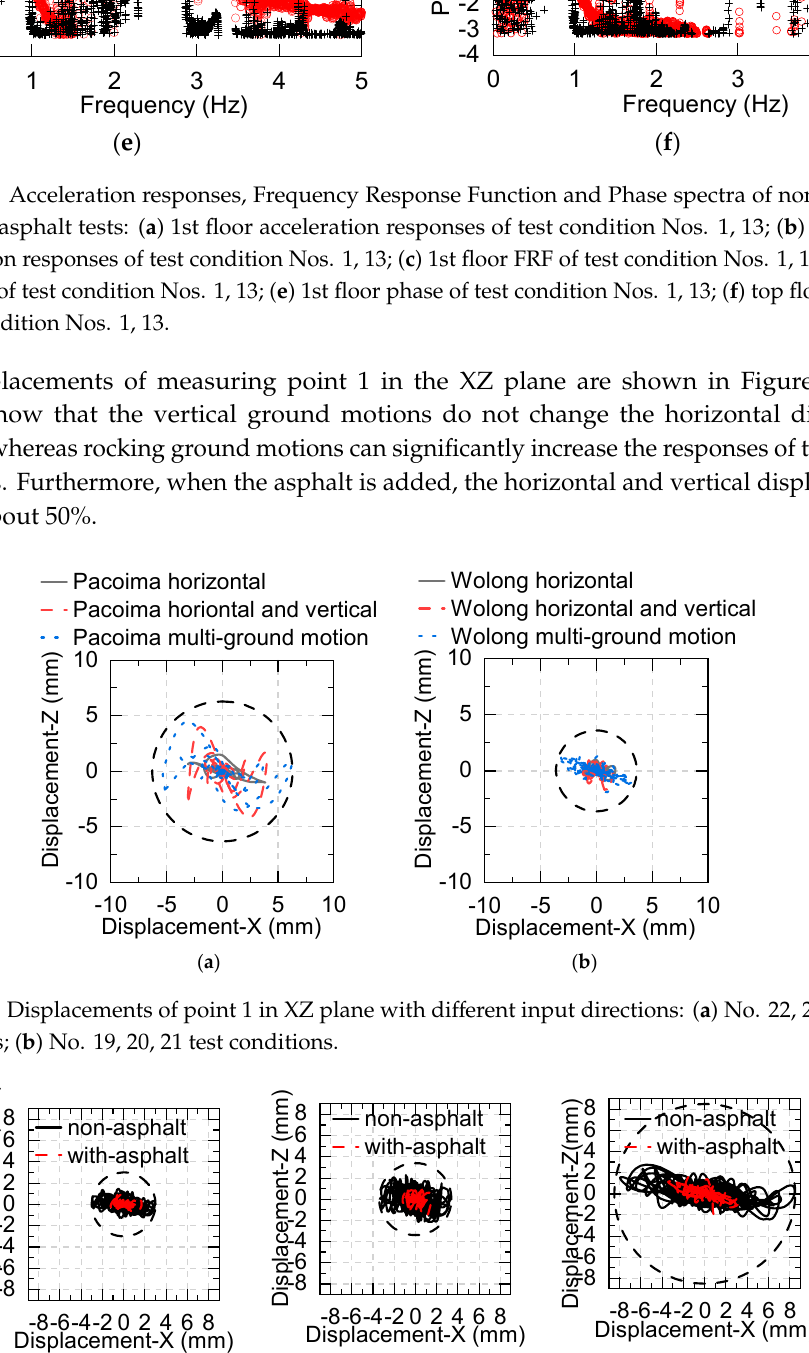
Figure 15. Acceleration responses, Frequency Response Function and Phase spectra of non-asphalt and with-asphalt tests: ( a ) 1st floor acceleration responses of test condition Nos. 1, 13; ( b ) top floor acceleration responses of test condition Nos. 1, 13; ( c ) 1st floor FRF of test condition Nos. 1, 13; ( d ) top floor FRF of test condition Nos. 1, 13; ( e ) 1st floor phase of test condition Nos. 1, 13; ( f ) top floor phase of test condition Nos. 1, 13